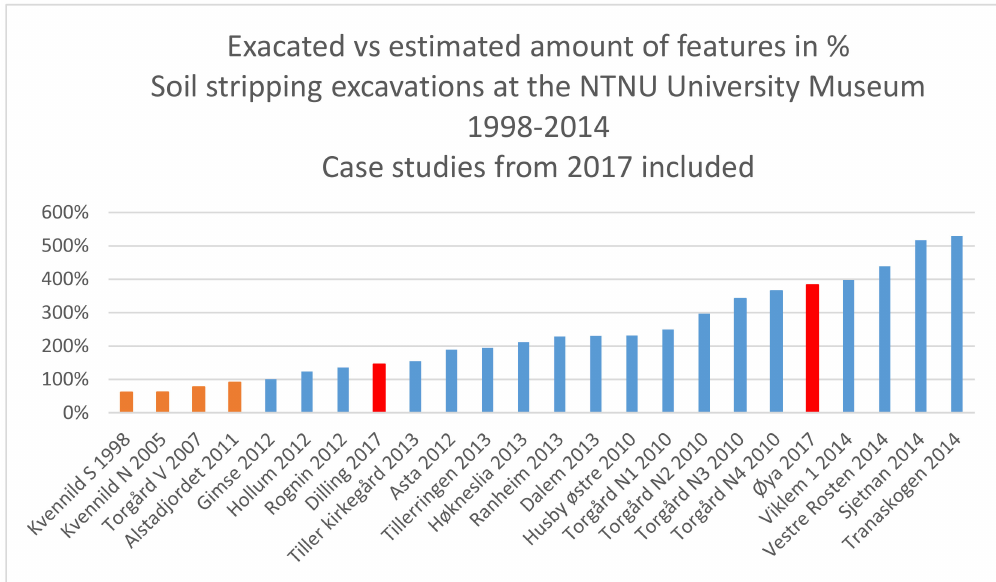
Figure 2. Graph showing the number of estimated archaeological features based on trial trenching versus features unearthed during full-scale excavations. Sites above 100% have more features than estimated. Orange bars indicate sites with fewer features than estimated. The graph is based on a selected number of excavations carried out by NTNU between 1998 and 2014, as well as the two case studies in this article in red. Data courtesy of Geir Grønnesby, Raymond Sauvage at NTNU in Trondheim, as well as Lars Erik Gjerpe at the Museum of Cultural History,